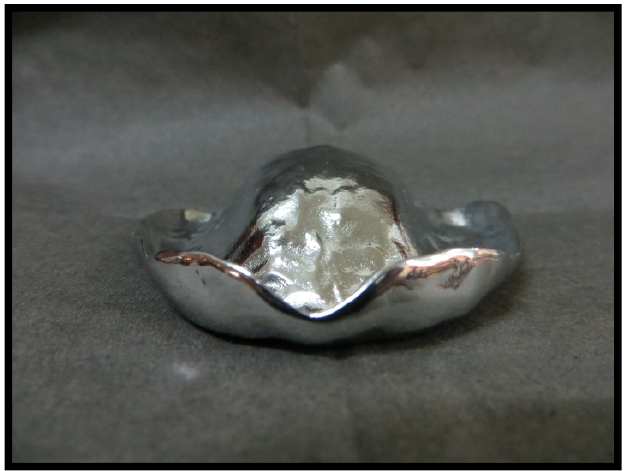
Figure 5. Cobalt–chromium spacer.